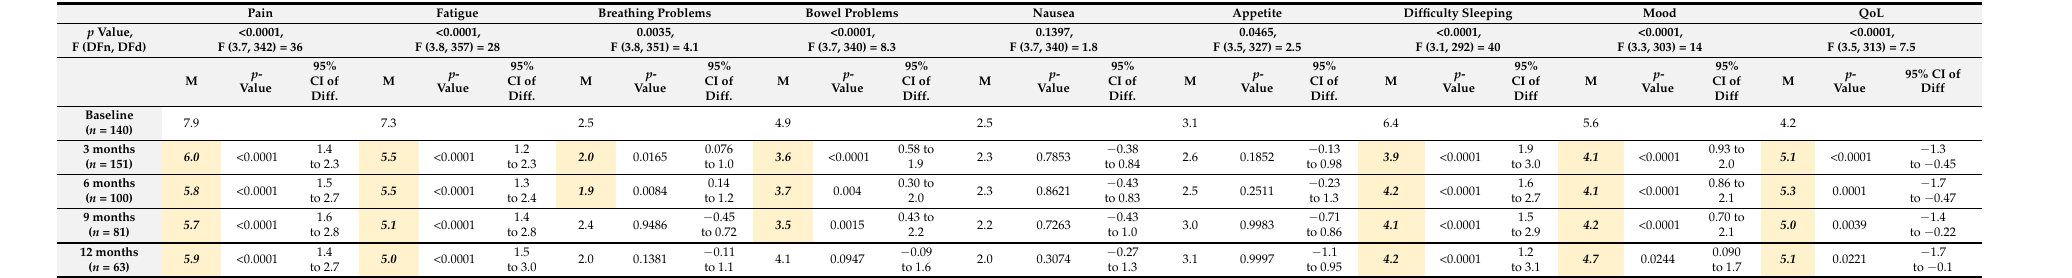
Table 2. Symptom assessment scale scores for all